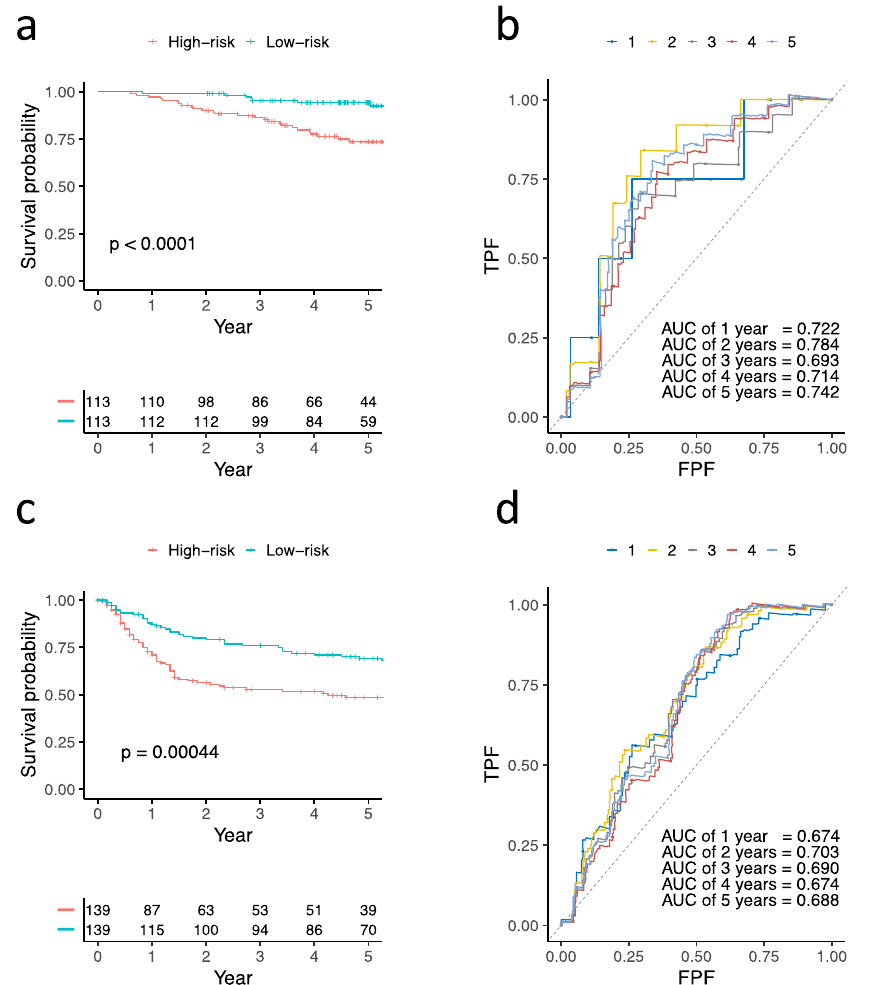
Figure 4. Validation of three prognostic genes by Kaplan–Meier survival analysis and time-dependent receiver operating characteristic analysis in GSE31210 ( a , b ) and GSE30219 ( c , d ). TPF: true positive fraction, FPF: false positive fraction.